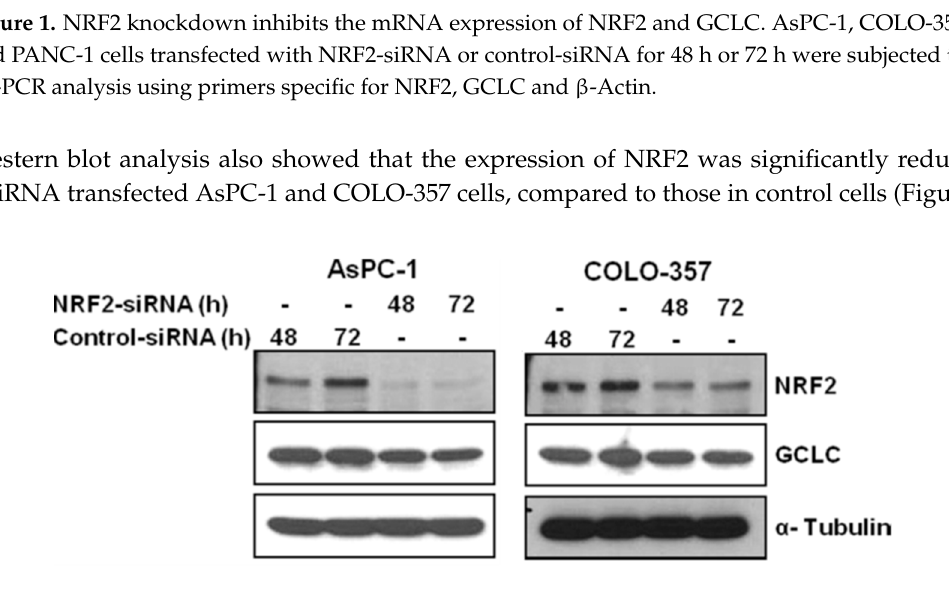
Figure 2. NRF2 knockdown inhibits the protein expression of NRF2 and GCLC. AsPC-1 and COLO-357 cells transfected with NRF2-siRNA or control-siRNA for 48 h and 72 h were subjected to western blot analysis using indicated antibodies. Anti- α -Tubulin antibody was used as a loading and transfer control.